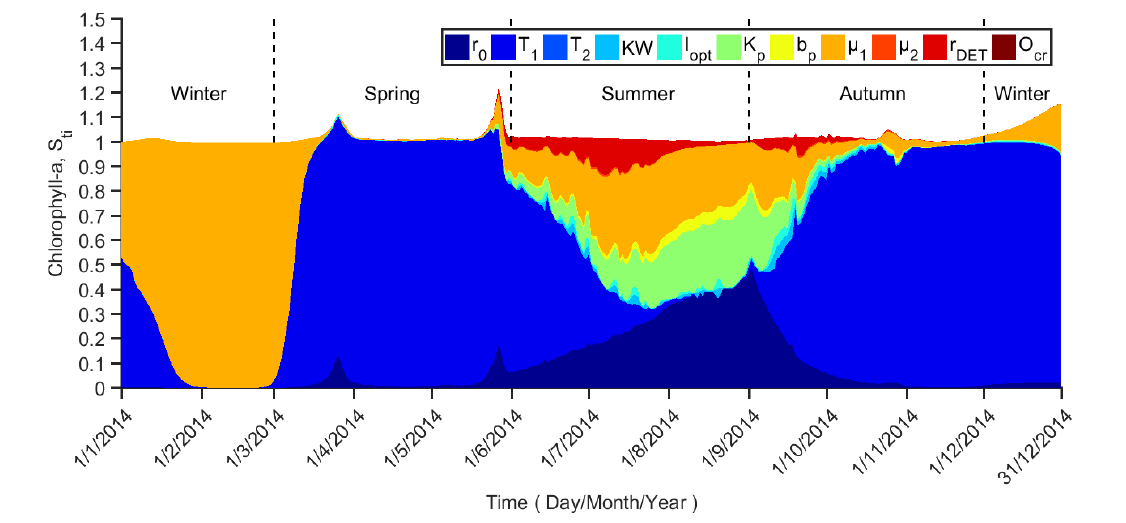
Figure 5. S ti profiles for Chlorophyll-a concentration.